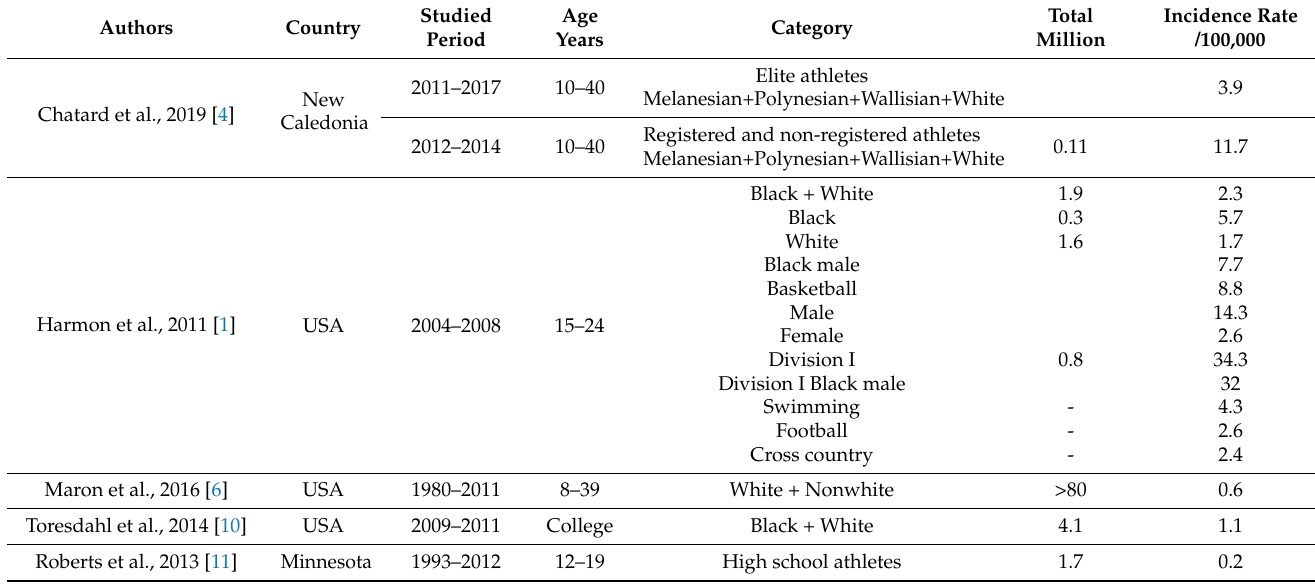
Table 2. Incidence rate of sudden cardiac death related to exercise in different countries: comparison between male and female, White and Black athletes, and